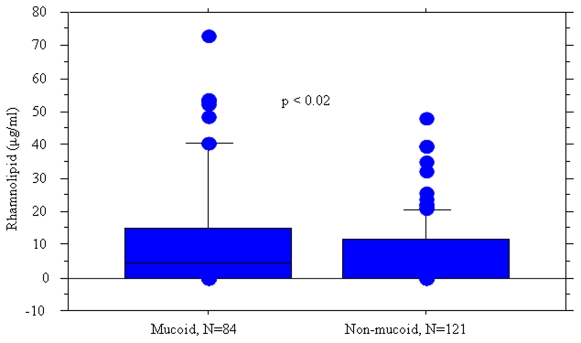
Distribution of rhamnolipid production in mucoid and nonmucoid isolates.Box and whisker plots represent the median (thick line inside the box), 10, 25, 75 and 90 centiles of the in vitro rhamnolipid production (µg/ml) of mucoid and non-mucoid P. aeruginosa isolates from chronically infected CF patients. Mann-Whitney test was used to investigate the significance of the difference between the groups.